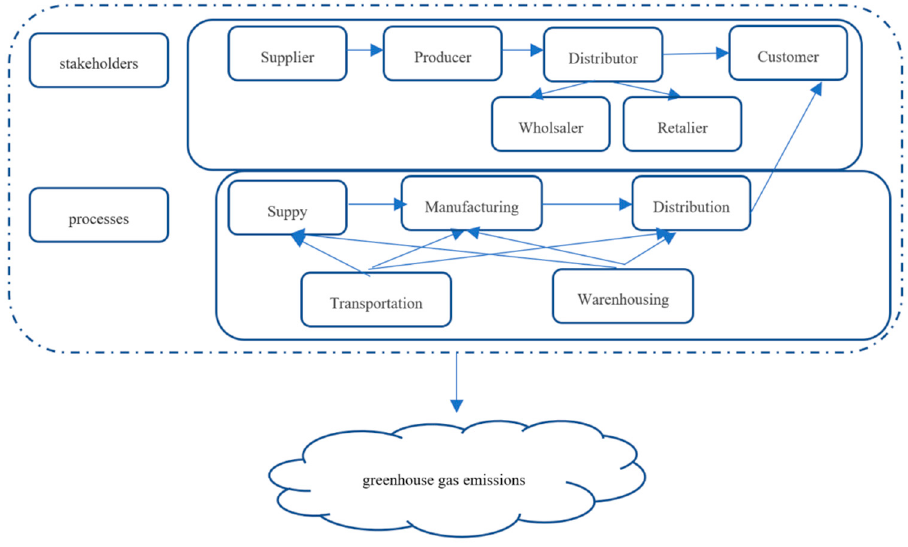
Figure 1. Identification of stakeholders and processes with the impact of GHG emission. Source: own elaboration.